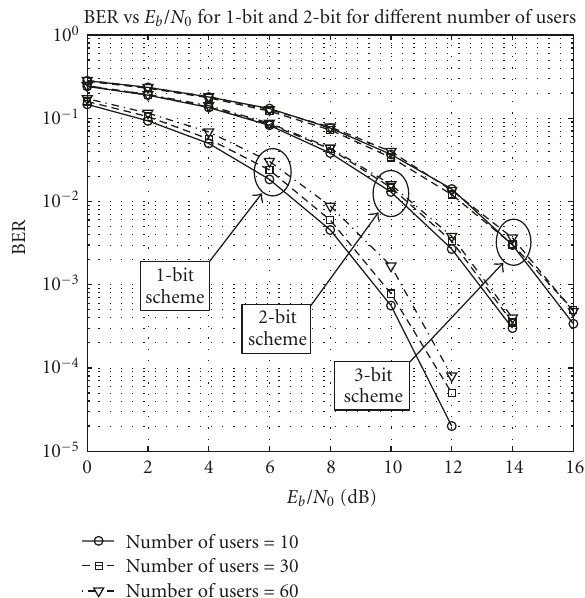
Figure 8: Performance of 1-bit, 2-bit, and 3-bit symbols transmis- sion of the OOK-PSM scheme for di ff erent numbers of users in AWGN.